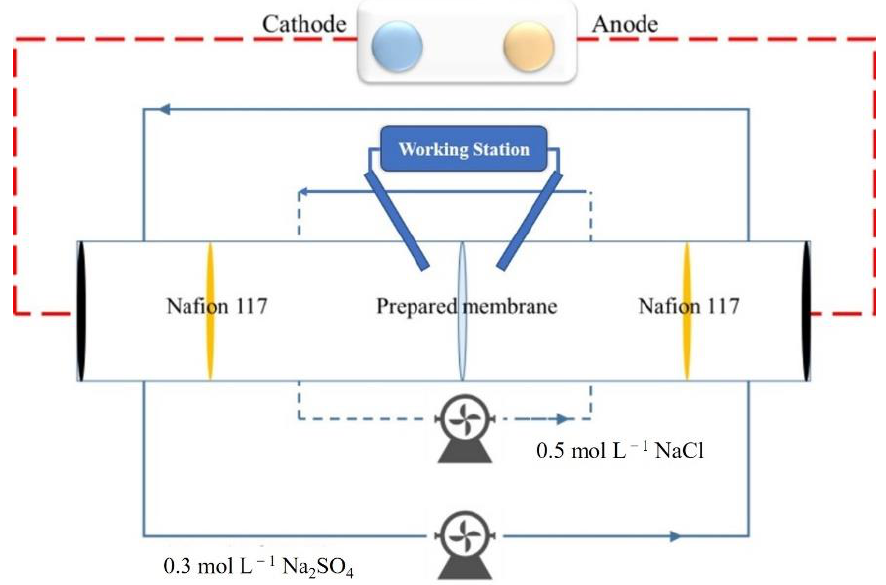
Figure 2. The schematic principle of area resistance measurement.